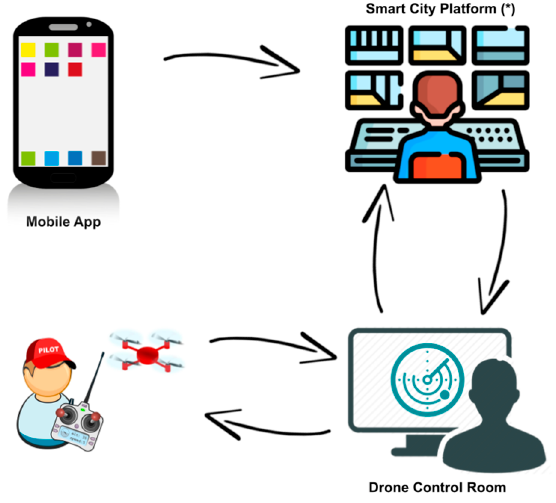
Figure 1. The main parts of the proposed system: the mobile application, the smart city platform which includes the application server (back end) and the web front end, and the system to plan and manage the inspections made by a drone. * Image from flaticon.com, accessed on 7 July 2022.